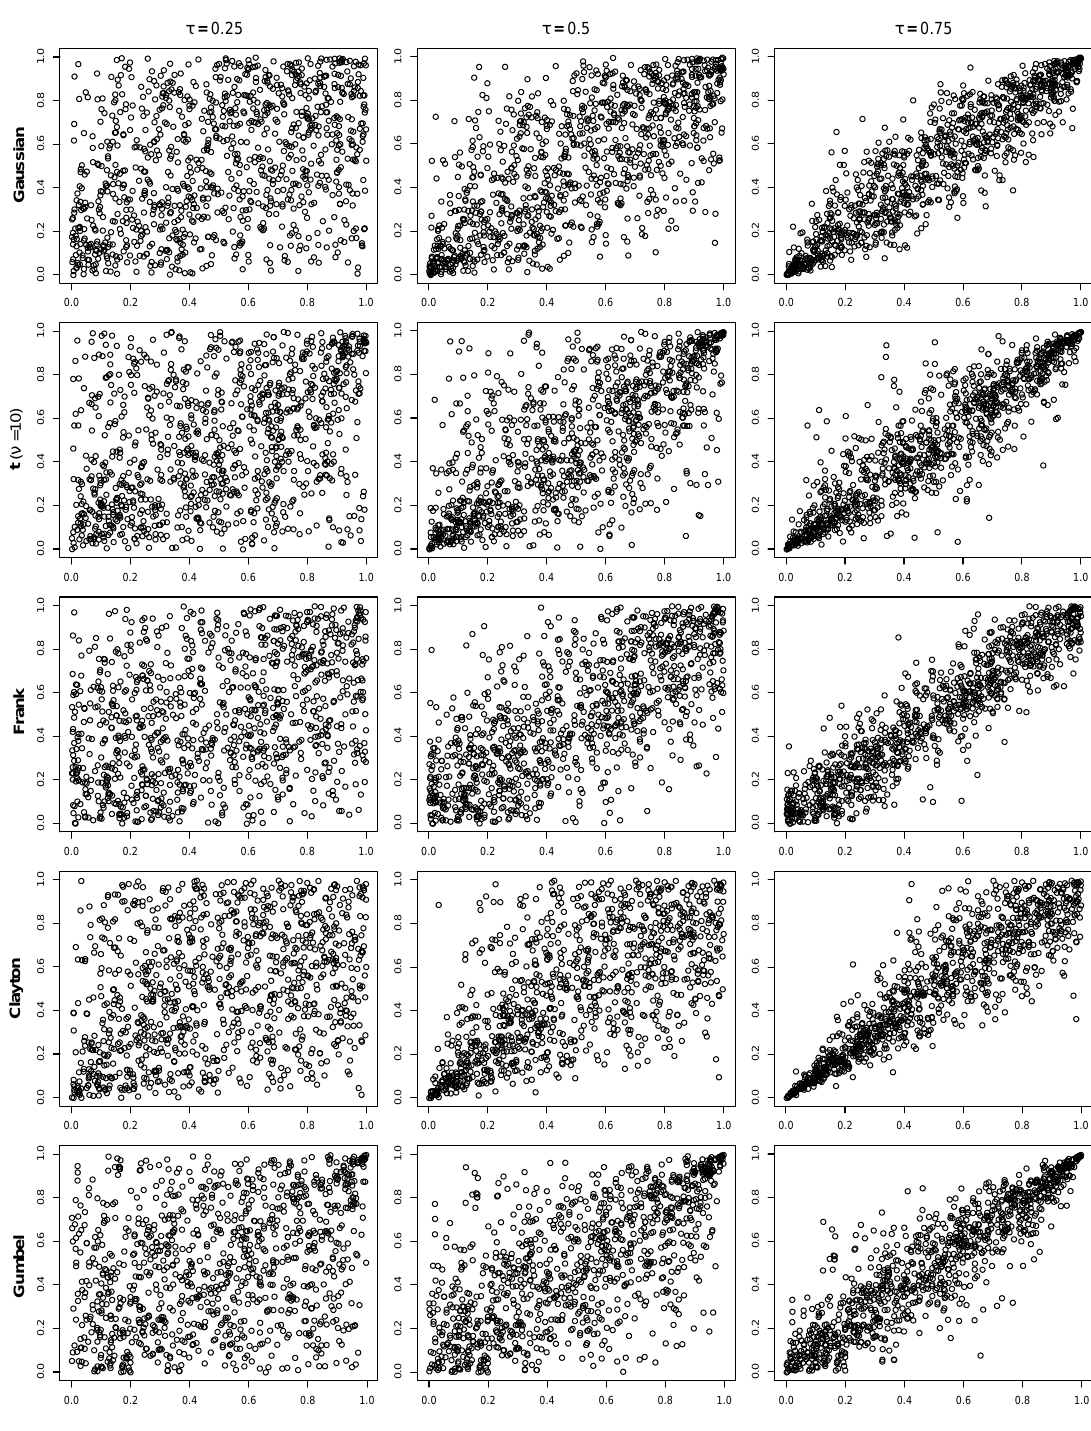
Figure 1: Scatter plots of random samples of size 1000 from the bivariate Gaussian, t (with ν = 10 ), Frank, Clayton and Gumbel copula (from top to bottom) with τ = 0.25 (left), 0.5 (middle), 0.75